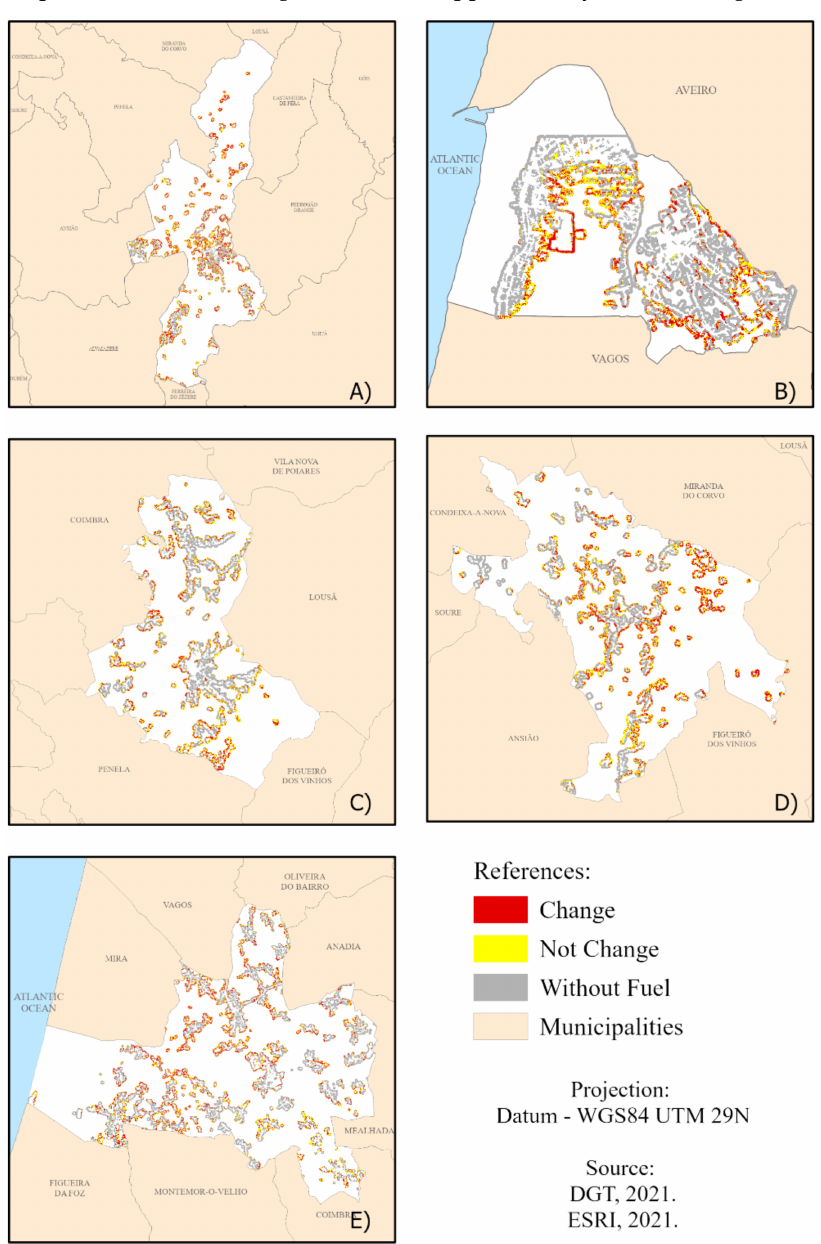
Figure 2. Changes detected in: ( A ) Figueir ó dos Vinhos, ( B ) Í lhavo, ( C ) Miranda do Corvo, ( D ) Penela, ( E ) Cantanhede, with p -value ≤